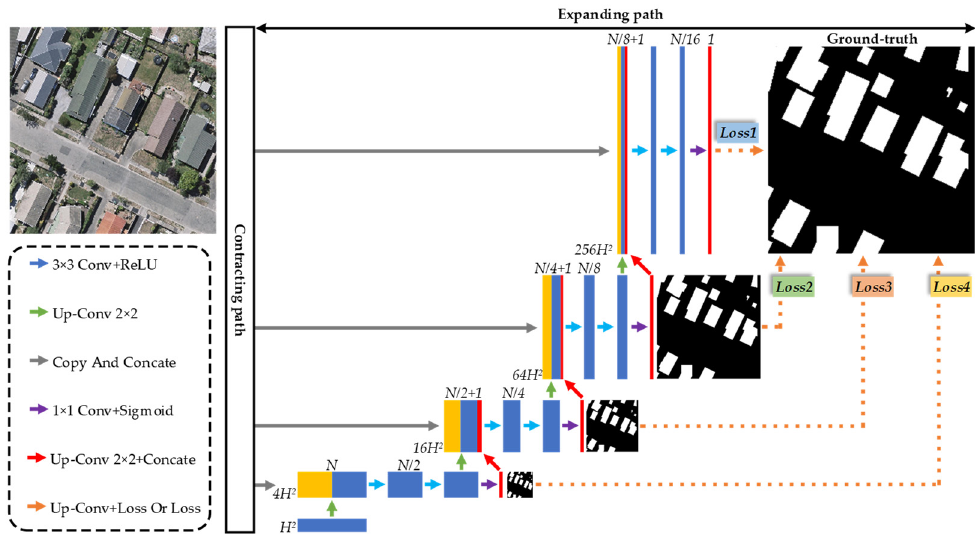
Figure 5. The architecture of the multiscale output fusion constraint (MOFC) structure.